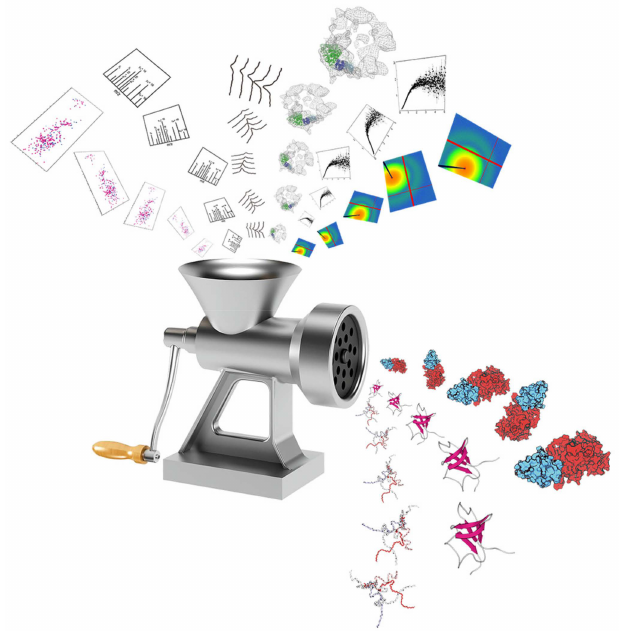
Figure 3. A schematic diagram for integrative biophysics combining various biophysical datasets. Complementary restraints from experimental studies of small-angle X-ray scattering, site-specific solvent accessibility, and various NMR techniques, as well as computations, are fed into ensemble- fitting machinery to generate a comprehensive picture for the ensemble structures of highly flexible biomolecules such as intrinsically disordered proteins. Reprinted with permission from Ref.